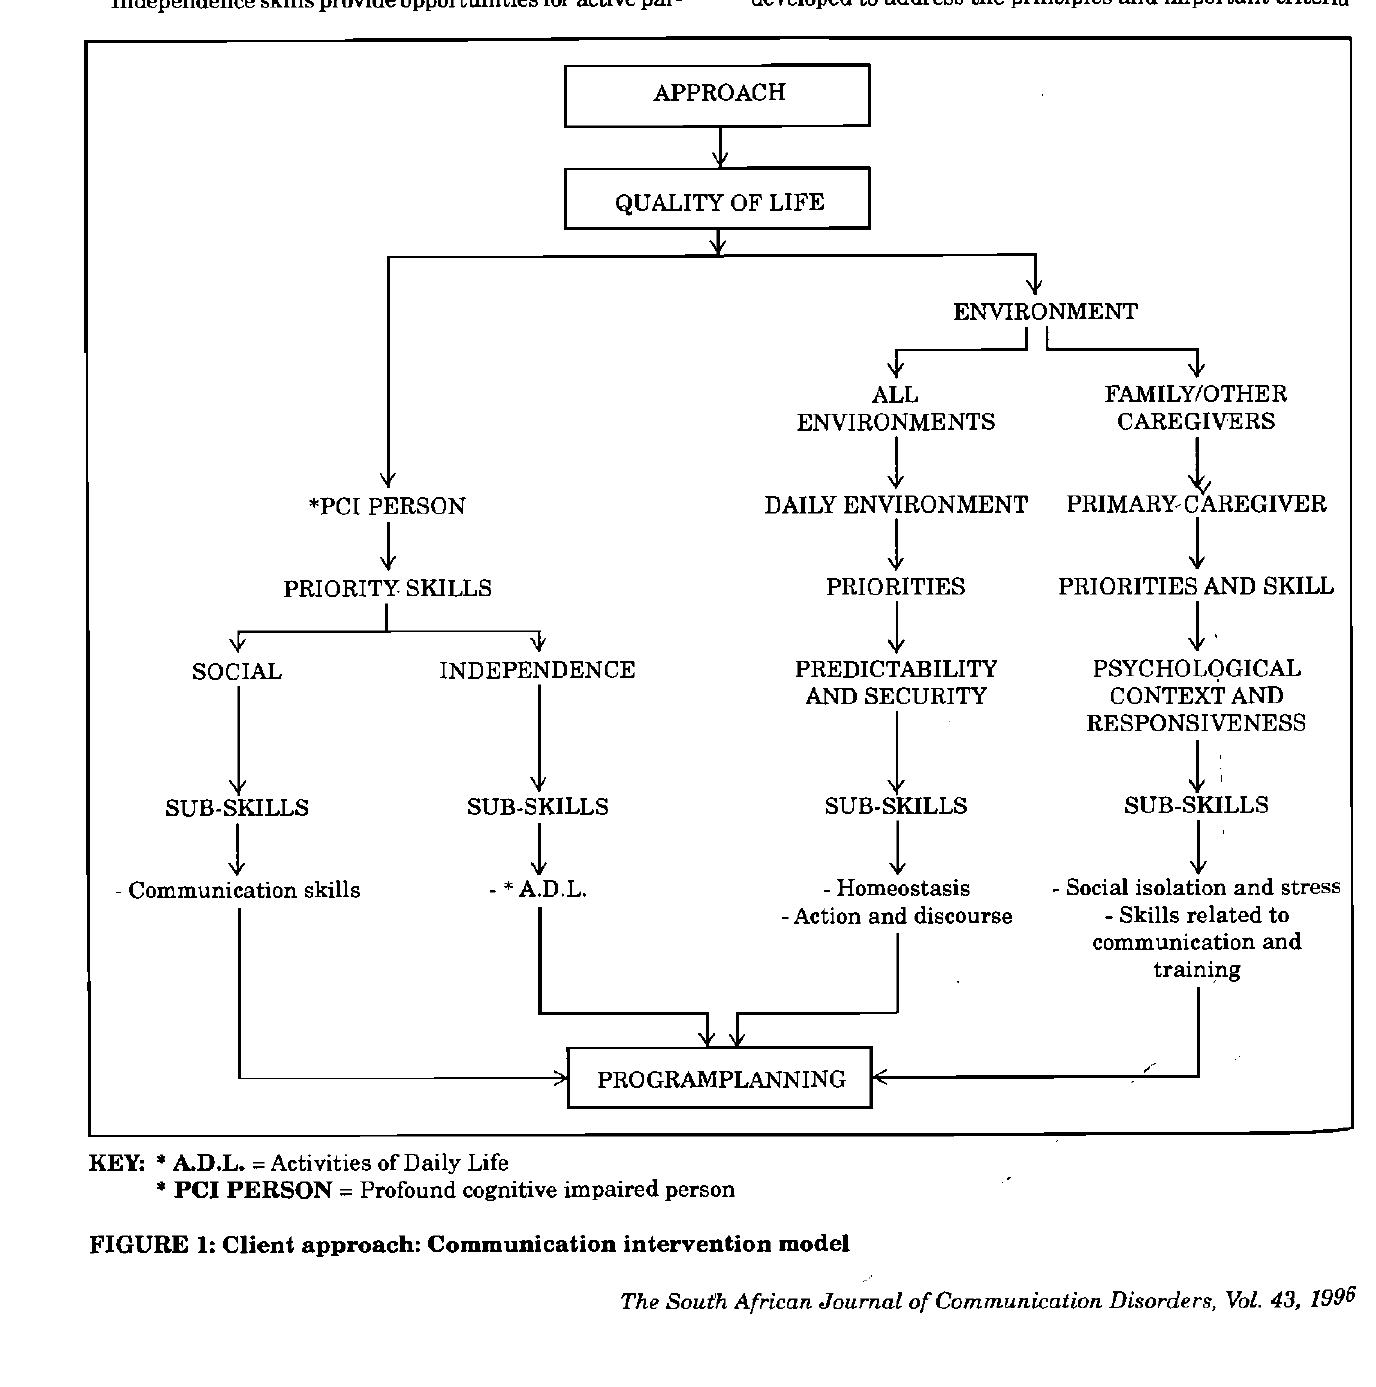
FIGURE 1: Client approach: Communication intervention